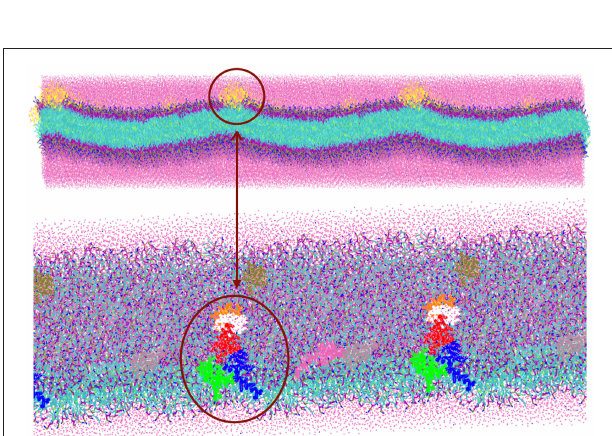
FIGURE 9 | View of the membrane curvature induced by the presence of a TFP